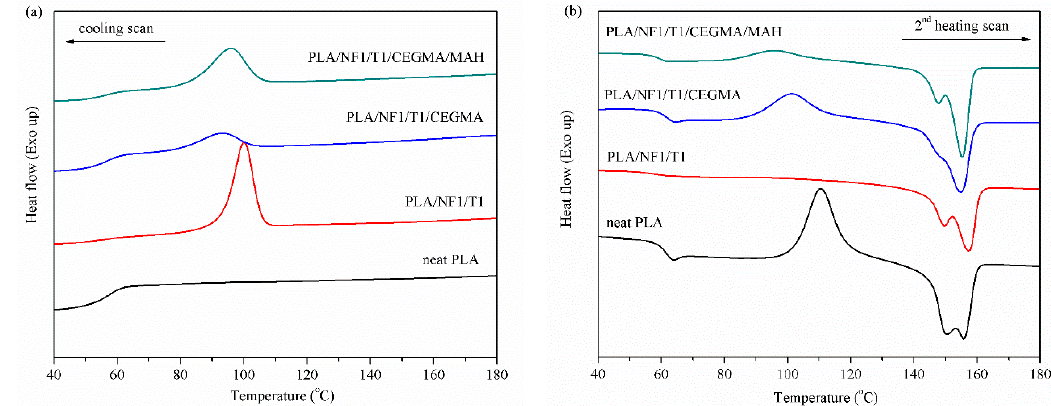
Figure 7. DSC thermograms of PLA hybrid composites with and without reactive compatibilizers at NF1/T1 ratio: ( a ) cooling scan and; ( b ) second heating scan.